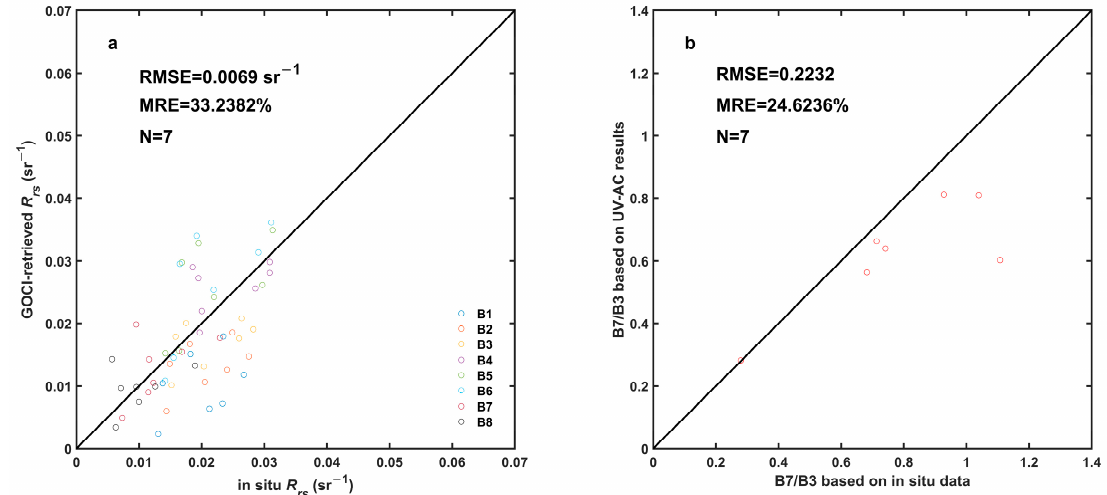
Figure 3. Comparison of R rs ( a ) and R rs (B7)/ R rs (B3) ( b ) between in situ measurements and data derived from the ultraviolet wavelength atmospheric correction (UV-AC) algorithm.